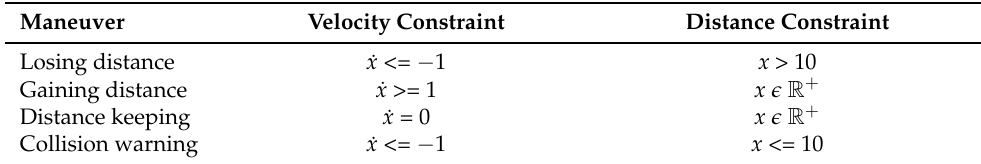
Table 4. Longitudinal maneuvers.